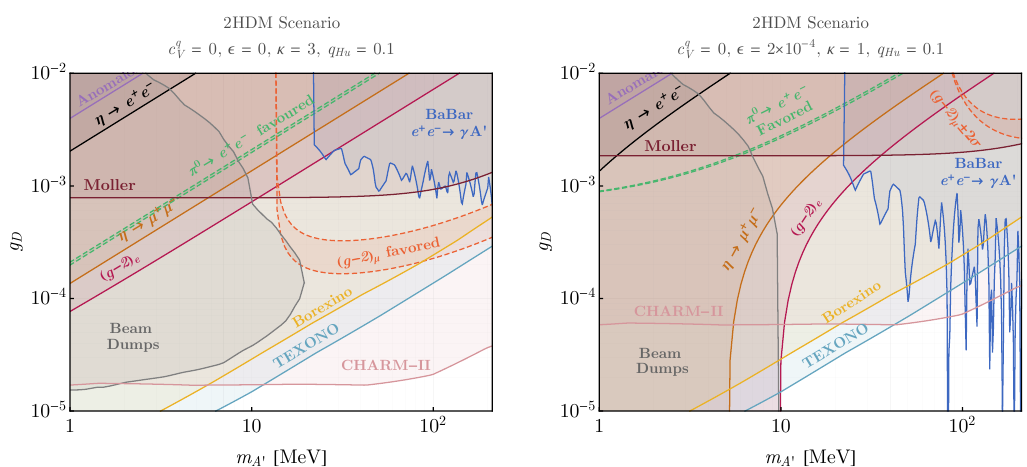
Figure 4 . Constraints on couplings in the 2HDM, with free parameters chosen so that c q all quarks, for di(cid:11)erent values of (cid:20) and (cid:15)